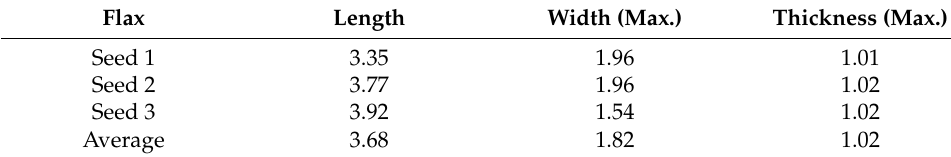
Table 5. Measurements (mm) of three flax seeds from